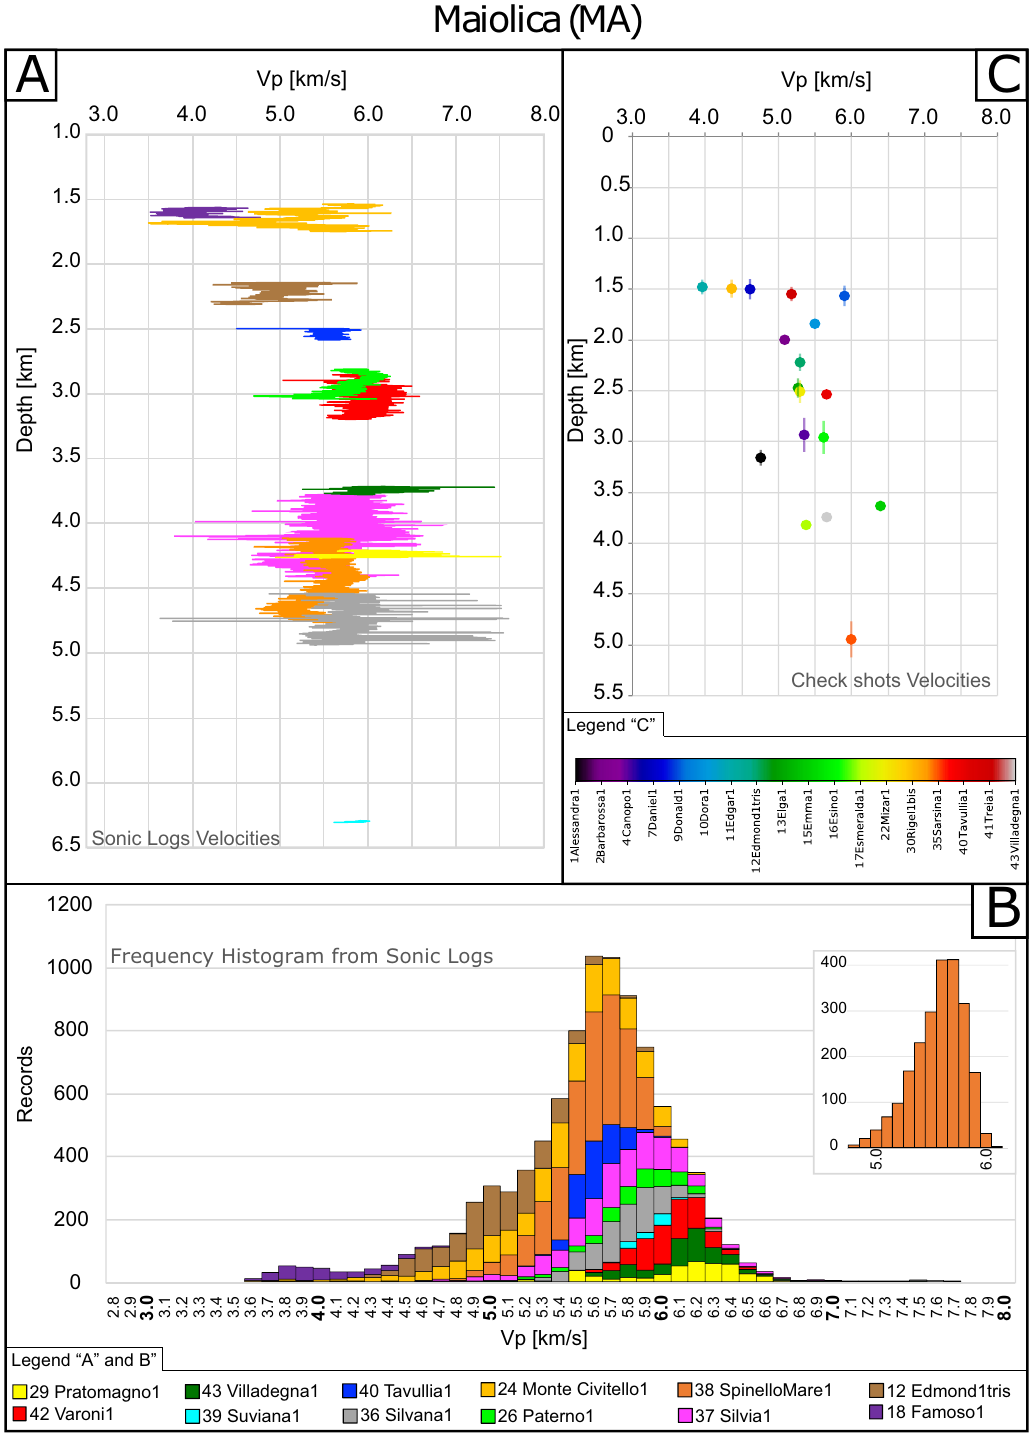
Figure 4. ( A ) In situ Vp sonic logs (SLV) depth profiles of boreholes through Maiolica (MA). ( B ) Velocity frequency cumulative histograms of the boreholes in panel A; y-Axis shows the number of times (frequency) that a certain velocity was recorded. Inset shows the frequency analysis of a representative single well (SpinelloMare1). ( C ) Interval velocities (IV) depth profile for available boreholes for the MA portions where vertical bars indicate the drilled thickness. Note that IV instrumental error is in the order of 2% (based on estimates in previous literature) 47 and that error bars are reported in Fig.